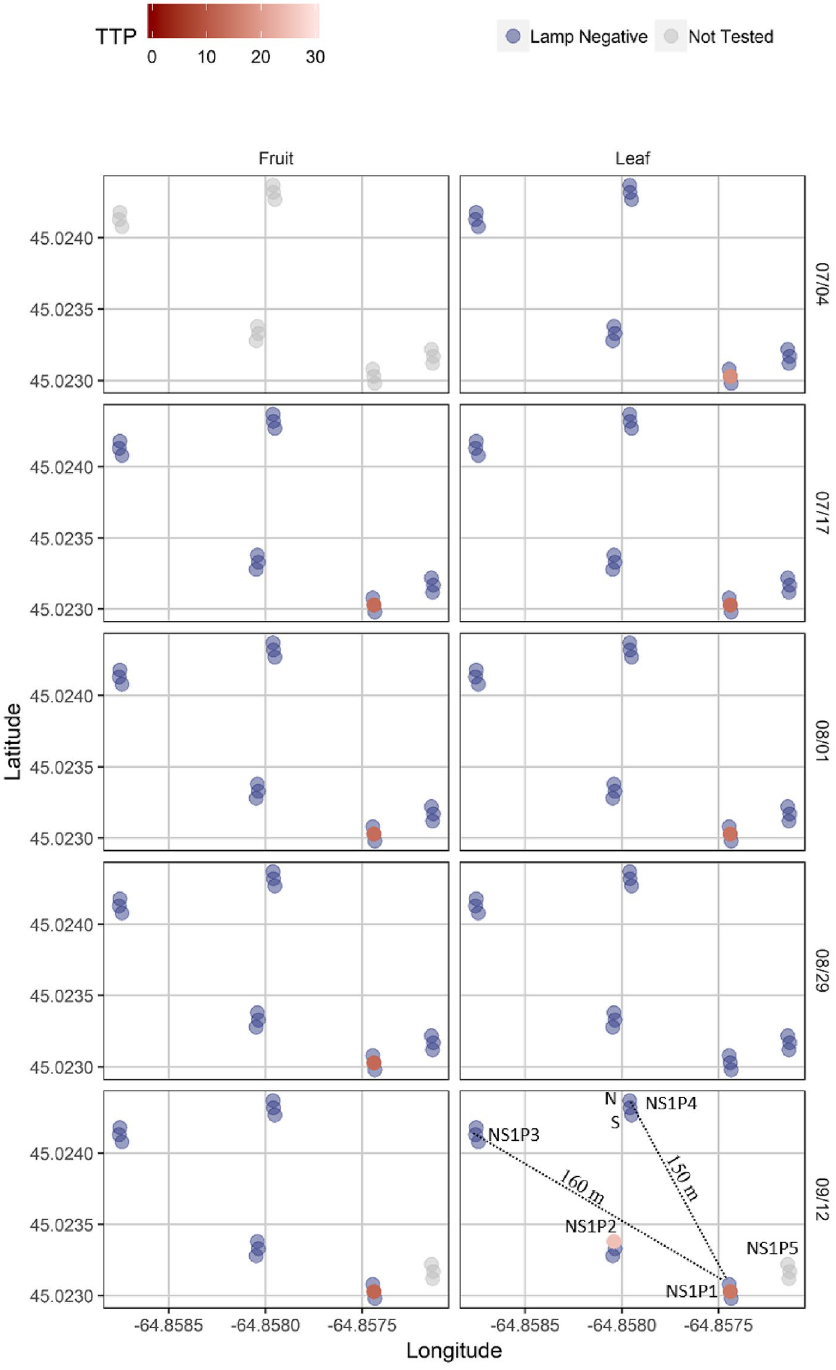
Figure 5. LAMP results on plants located at site NS1 close to a chronically infected plant (NS1P1). Sampling dates (month/day) are from